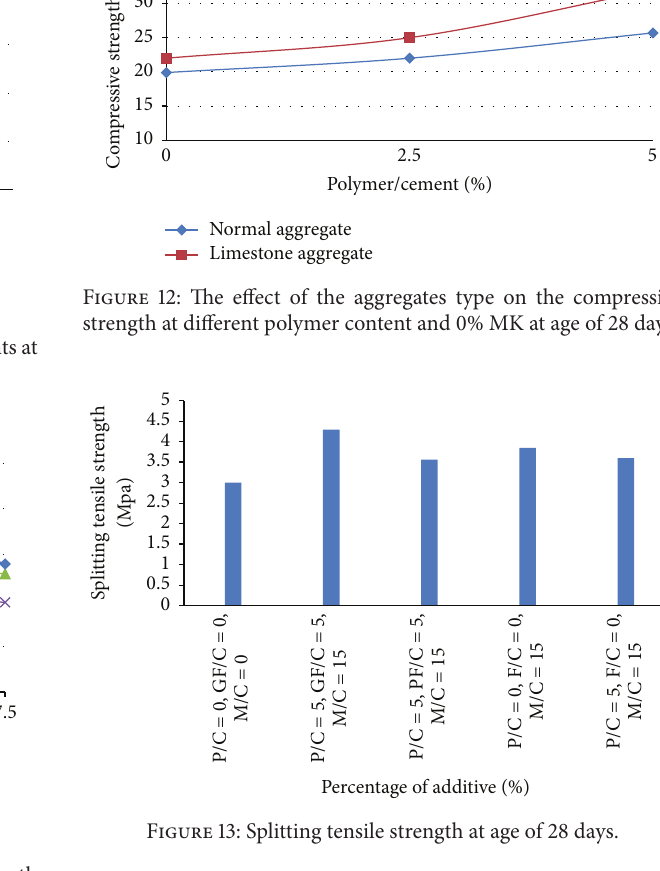
Figure 10: The effect of curing methods on the compressive strength at different polymer contents and 0% MK at age of 28 days.